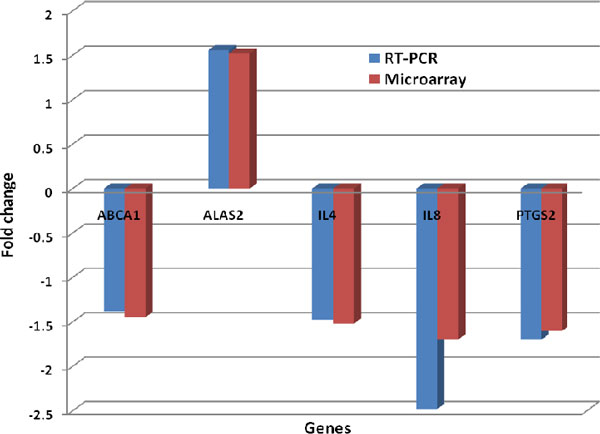
Expression concordance between microarray and quantitative real-time PCR assays. The y-axis represents the ratio of expression values between the T2D and control groups.